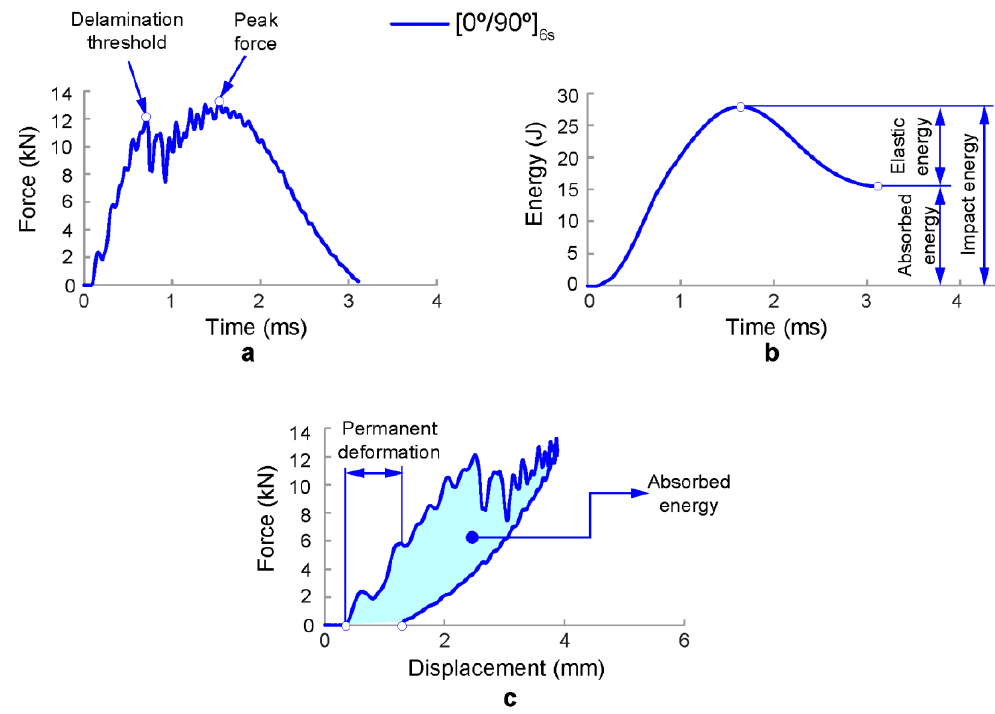
Figure 3. Impact damage response histories of typical composite laminates under drop-weight impact test: ( a ) force–time history, ( b ) energy–time history, and ( c ) force–displacement history [3].